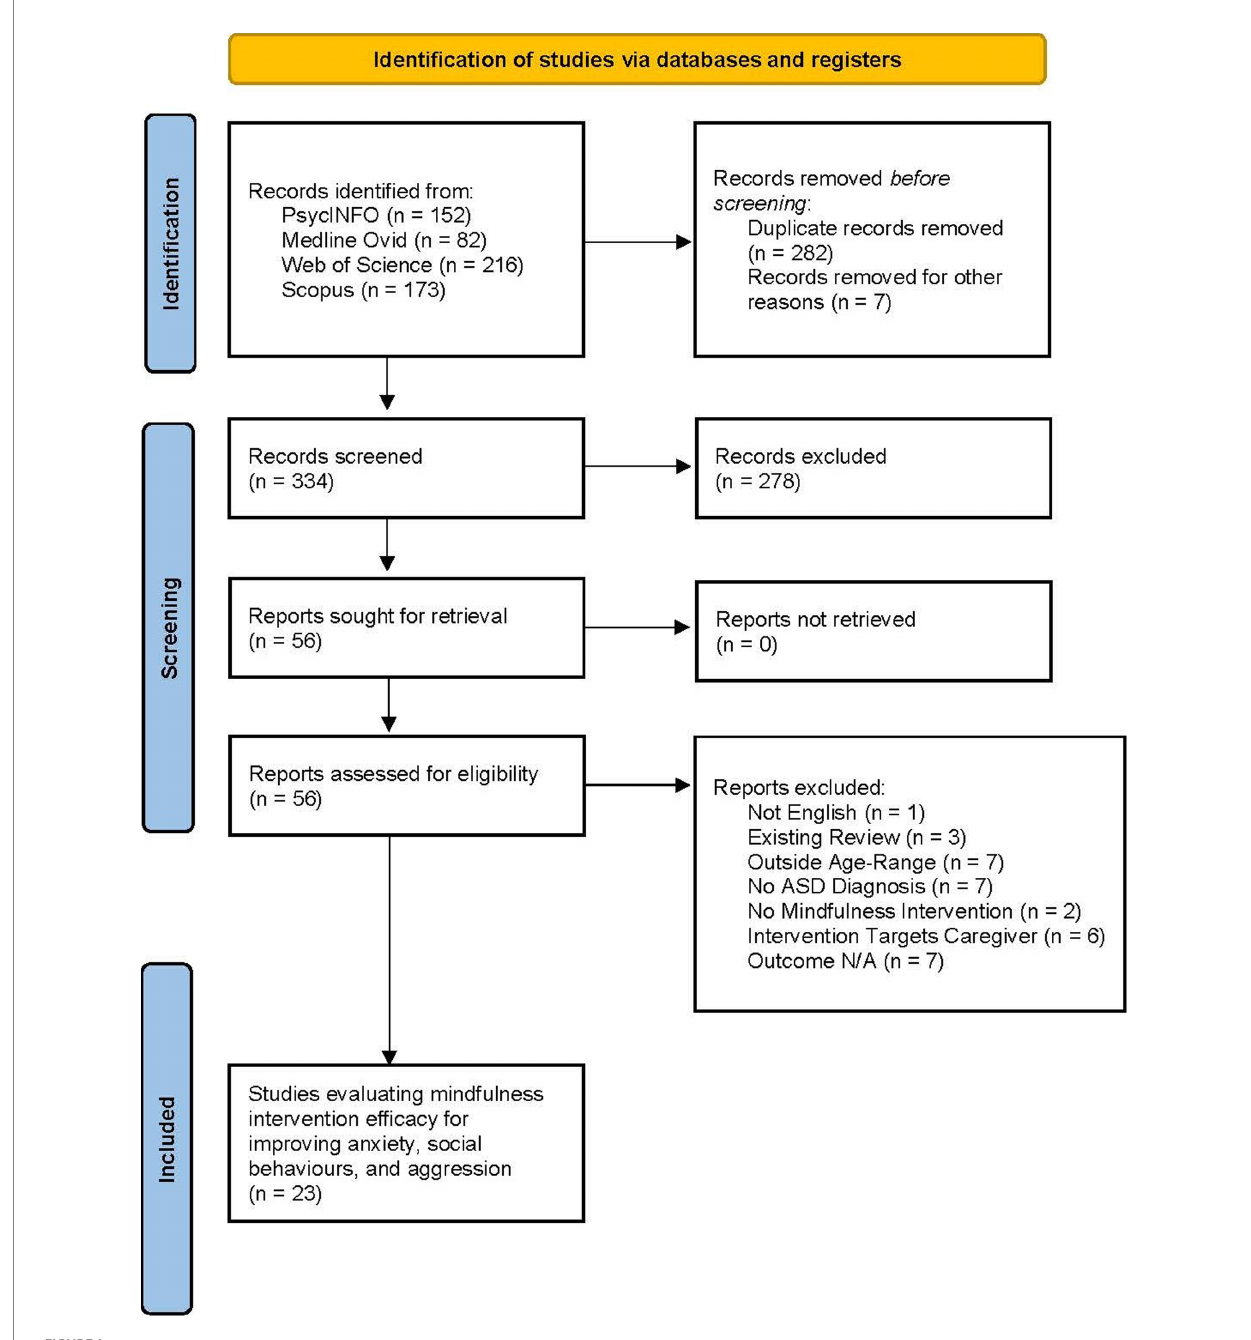
FIGURE 1 Article selection process – PRISMA table drawn from Page et al.